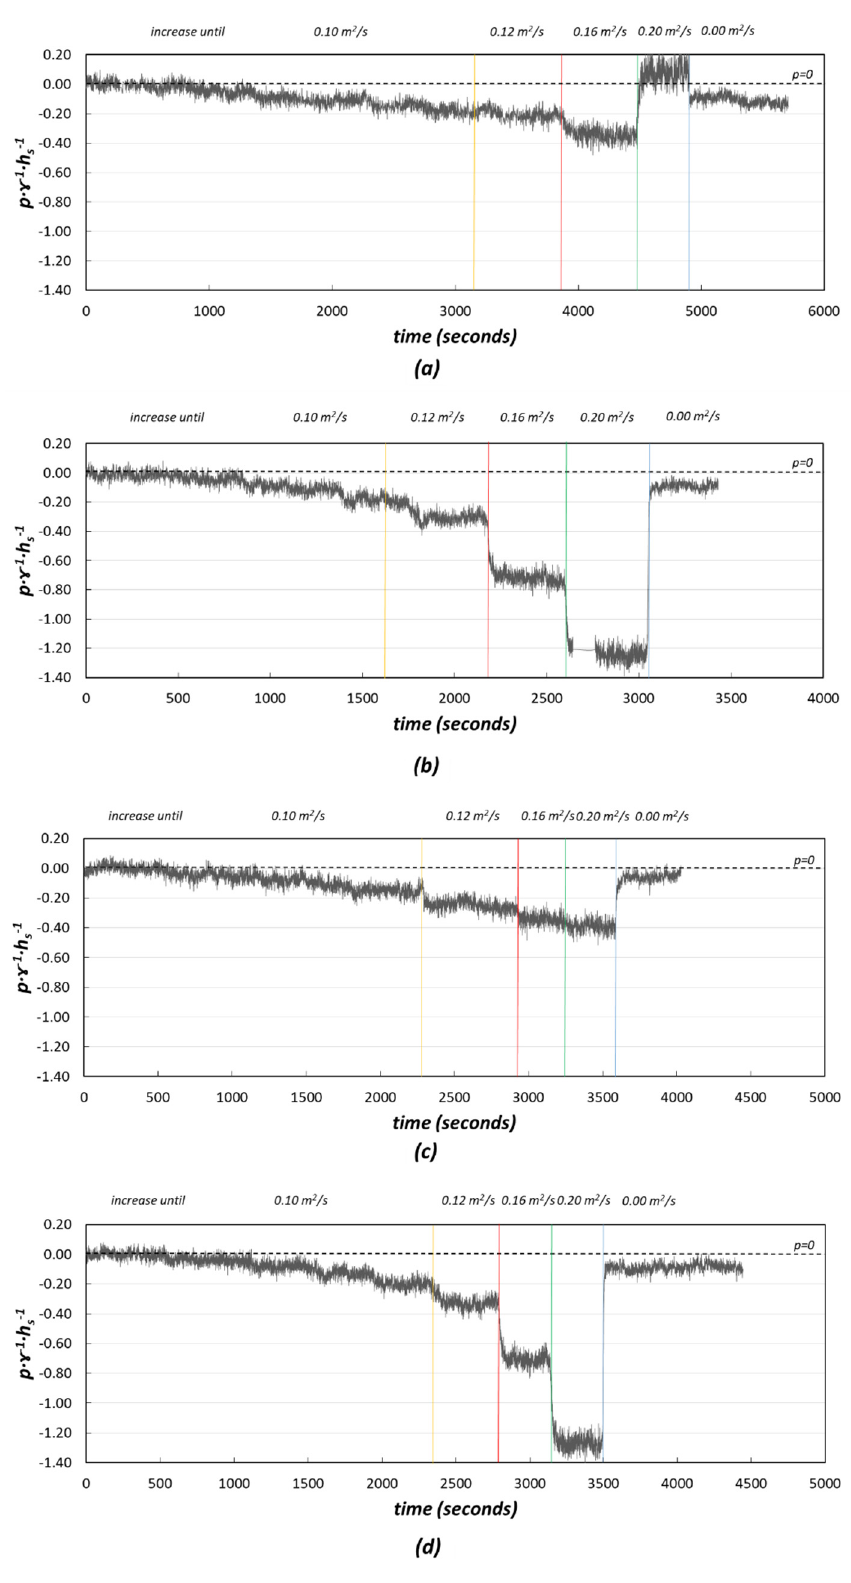
Figure 22. Hydrodynamic pressures on the base in row 25 for unit flow rates ( q ) from 0.04 to 0.24 m 2 s − 1 and return to non-discharge. Longitudinal joints sealing: ( a ) Armorwedge TM block ( w 1) and ( b ) ACUÑA block ( w 2). Complete sealing of the joints: ( c ) Armorwedge TM block and ( d ) ACUÑA block.